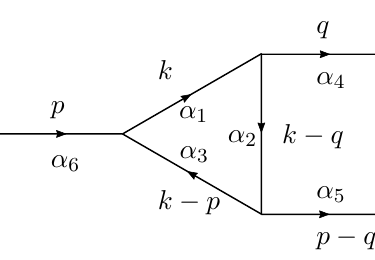
Figure 11 . The one-loop diagram corresponding to the integral (A.7). Here the labels (cid:11) i on the various lines denote the exponents of the propagators appearing in the